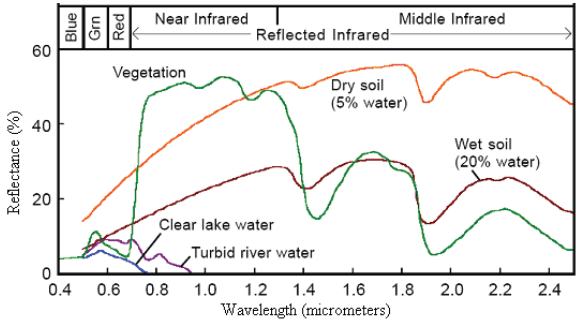
Figure 4. Surface Reflection of Light with respect to natural environment (Mercan and Alam, 2011).